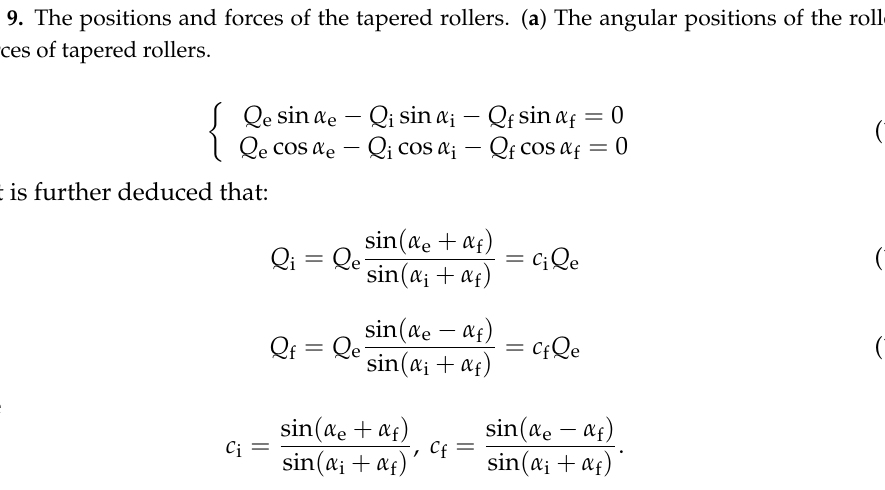
Figure 9. The positions and forces of the tapered rollers. ( a ) The angular positions of the rollers; ( b ) Forces of tapered rollers.